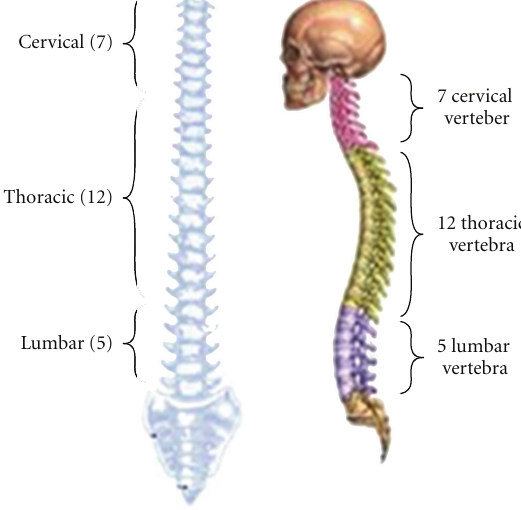
Figure 3: The human spine vertebra.